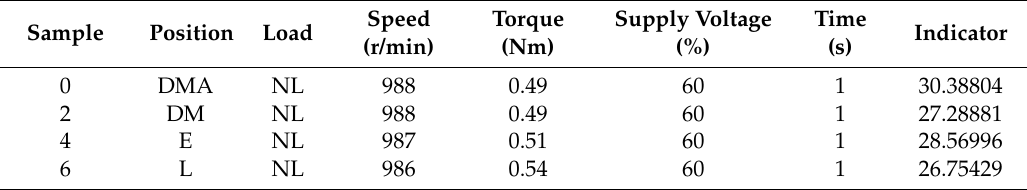
Table 6. Results of the indicator in the frequency domain based on Equations (4) and (5) for the data of the experiment with the healthy motor during